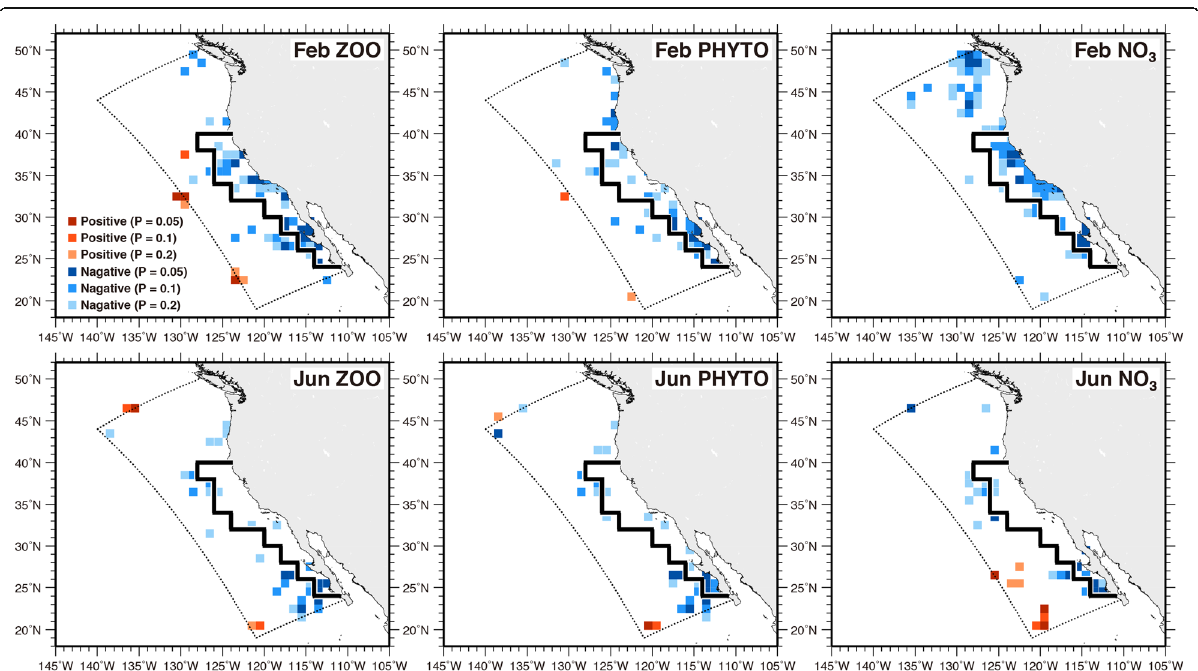
Fig. 11 Spatial distribution of detections of regime shifts by the RSI for 1977 in the historical simulation. For February and June, the detections are shown for small plus large zooplankton densities, small plus large phytoplankton densities, and for nitrate concentration. Solid lines represent the boundary between the coastal region and offshore region, and broken lines represent a boundary of the model domain used for averaging values between the two